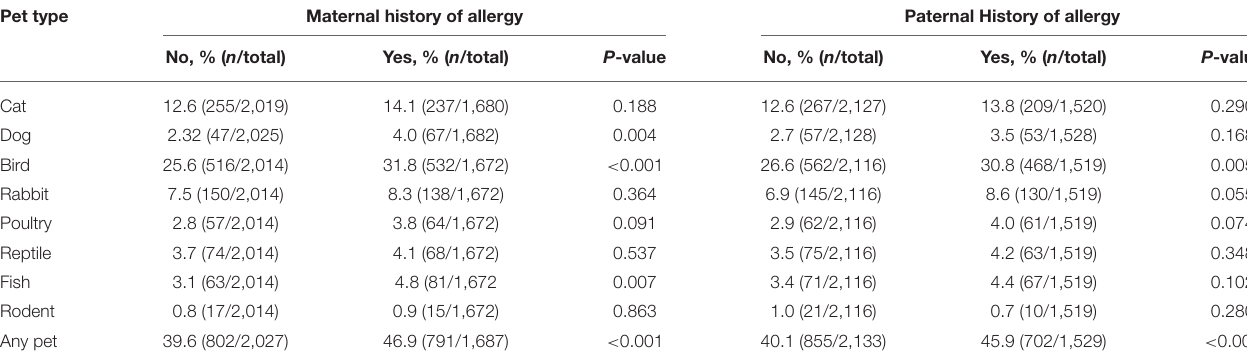
TABLE 3 | Prevalence estimates of pet-keeping according to maternal and paternal history of allergy. Pet type